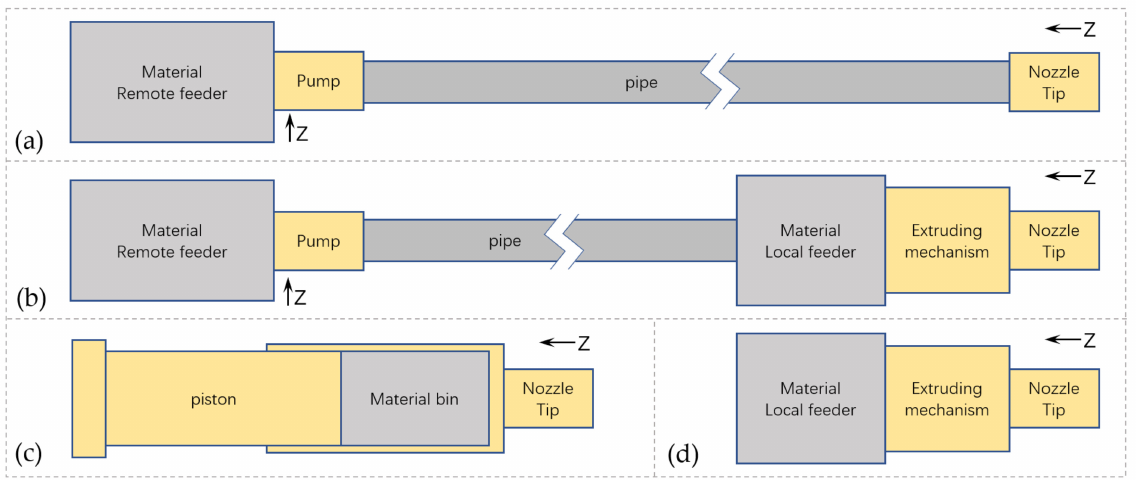
Figure 5. Four types of material systems in the existing research. ( a ). a remote feeder only, ( b ) a remote and a local feeder, ( c ) a ram extruder, and ( d ) a local feeder